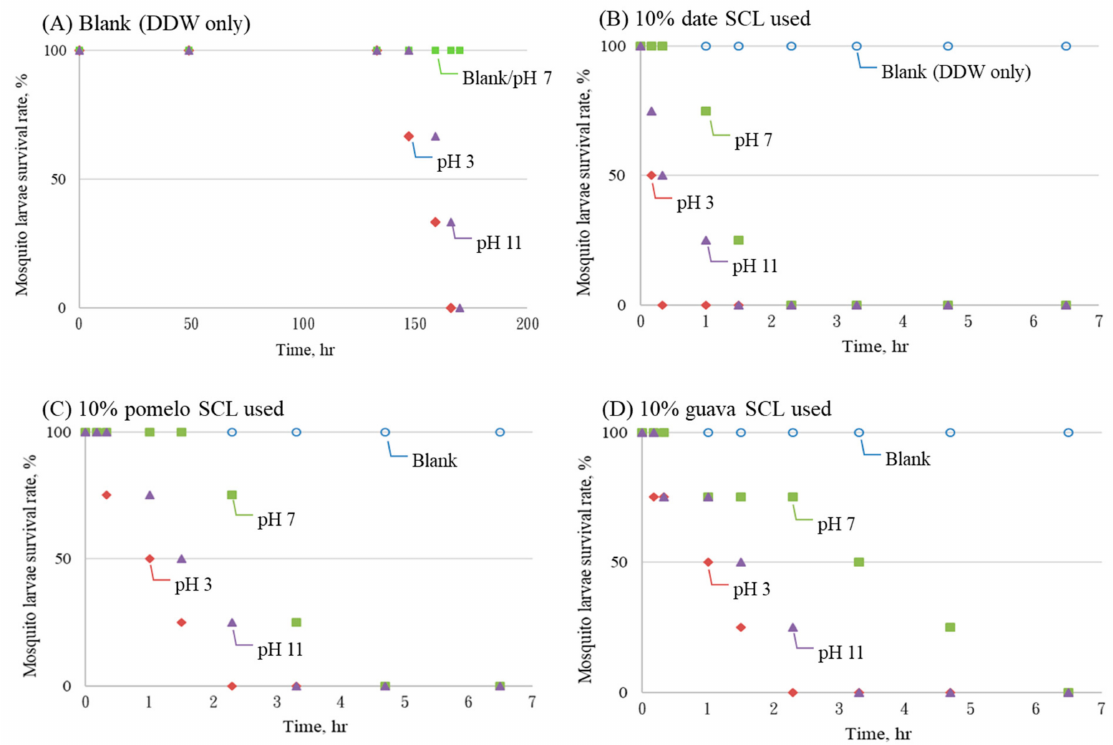
Figure 9. Larval survival rates at various pHs in 10% of the three